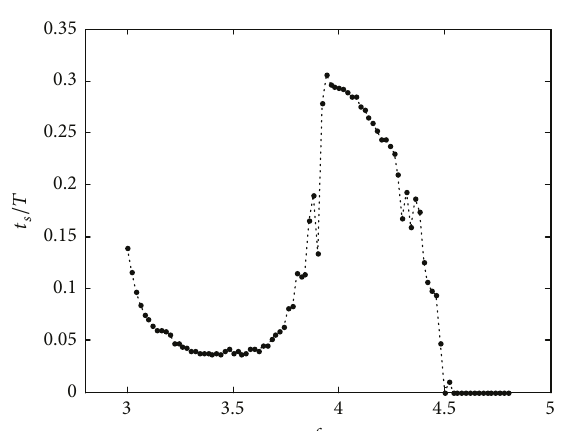
Figure 10: Sliding time duty